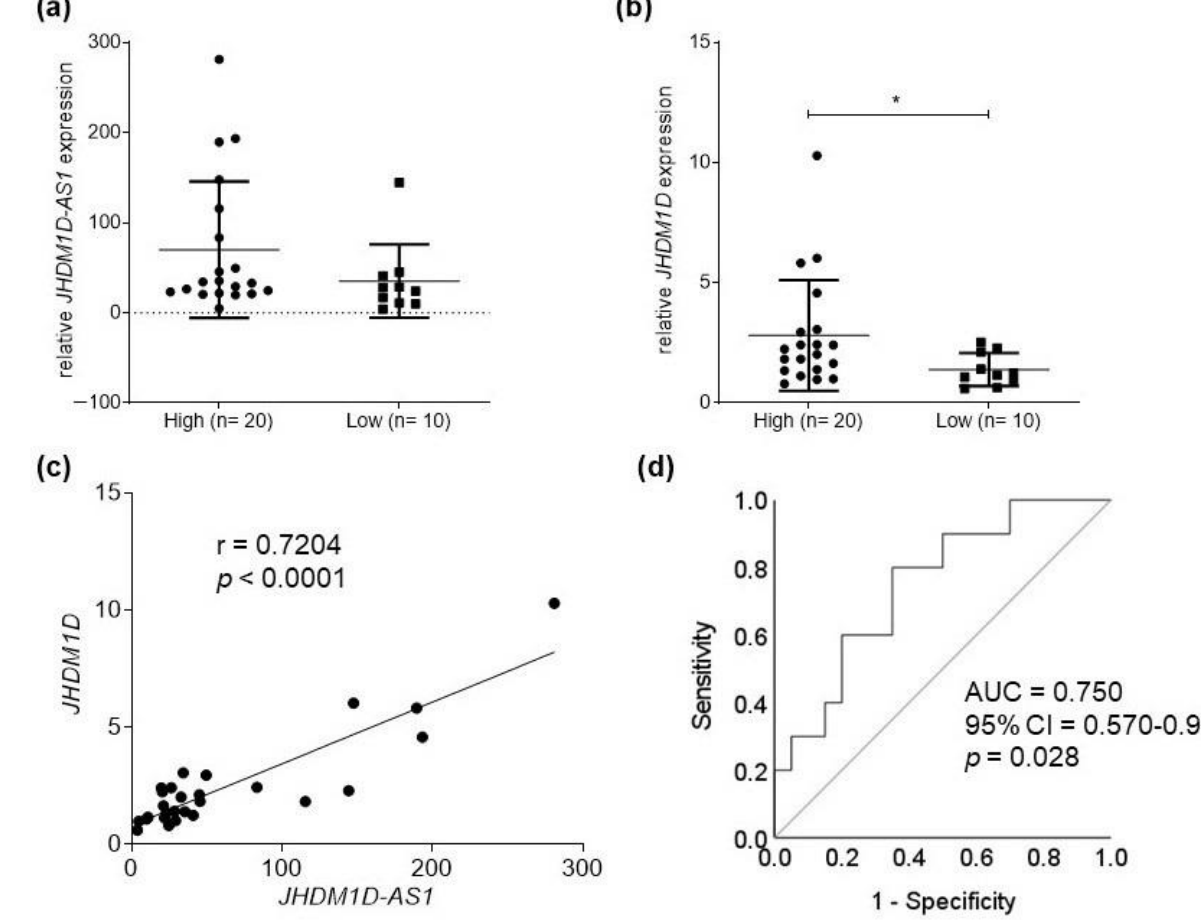
Figure 1. Expression of the JHDM1D gene ( a ) and JHDM1D-AS1 lncRNA ( b ) in patients with low- and high-grade bladder tumors. ( c ) Moderately positive correlation between JHDM1D and JHDM1D-AS1 expression (r = 0.7204) in low- and high-grade bladder tumor samples (Spearman correlation analysis). ( d ) Receiver operating characteristics (ROC) curves using the combination between JHDM1-AS1 and JHDM1D to distinguish between low- and high-grade bladder tumors. * p < 0.05.